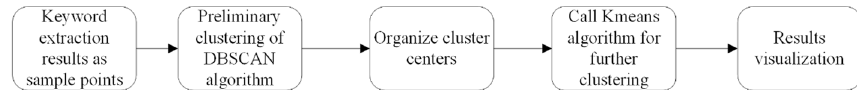
Fig. 2 Flowchart of DB-Kmeans